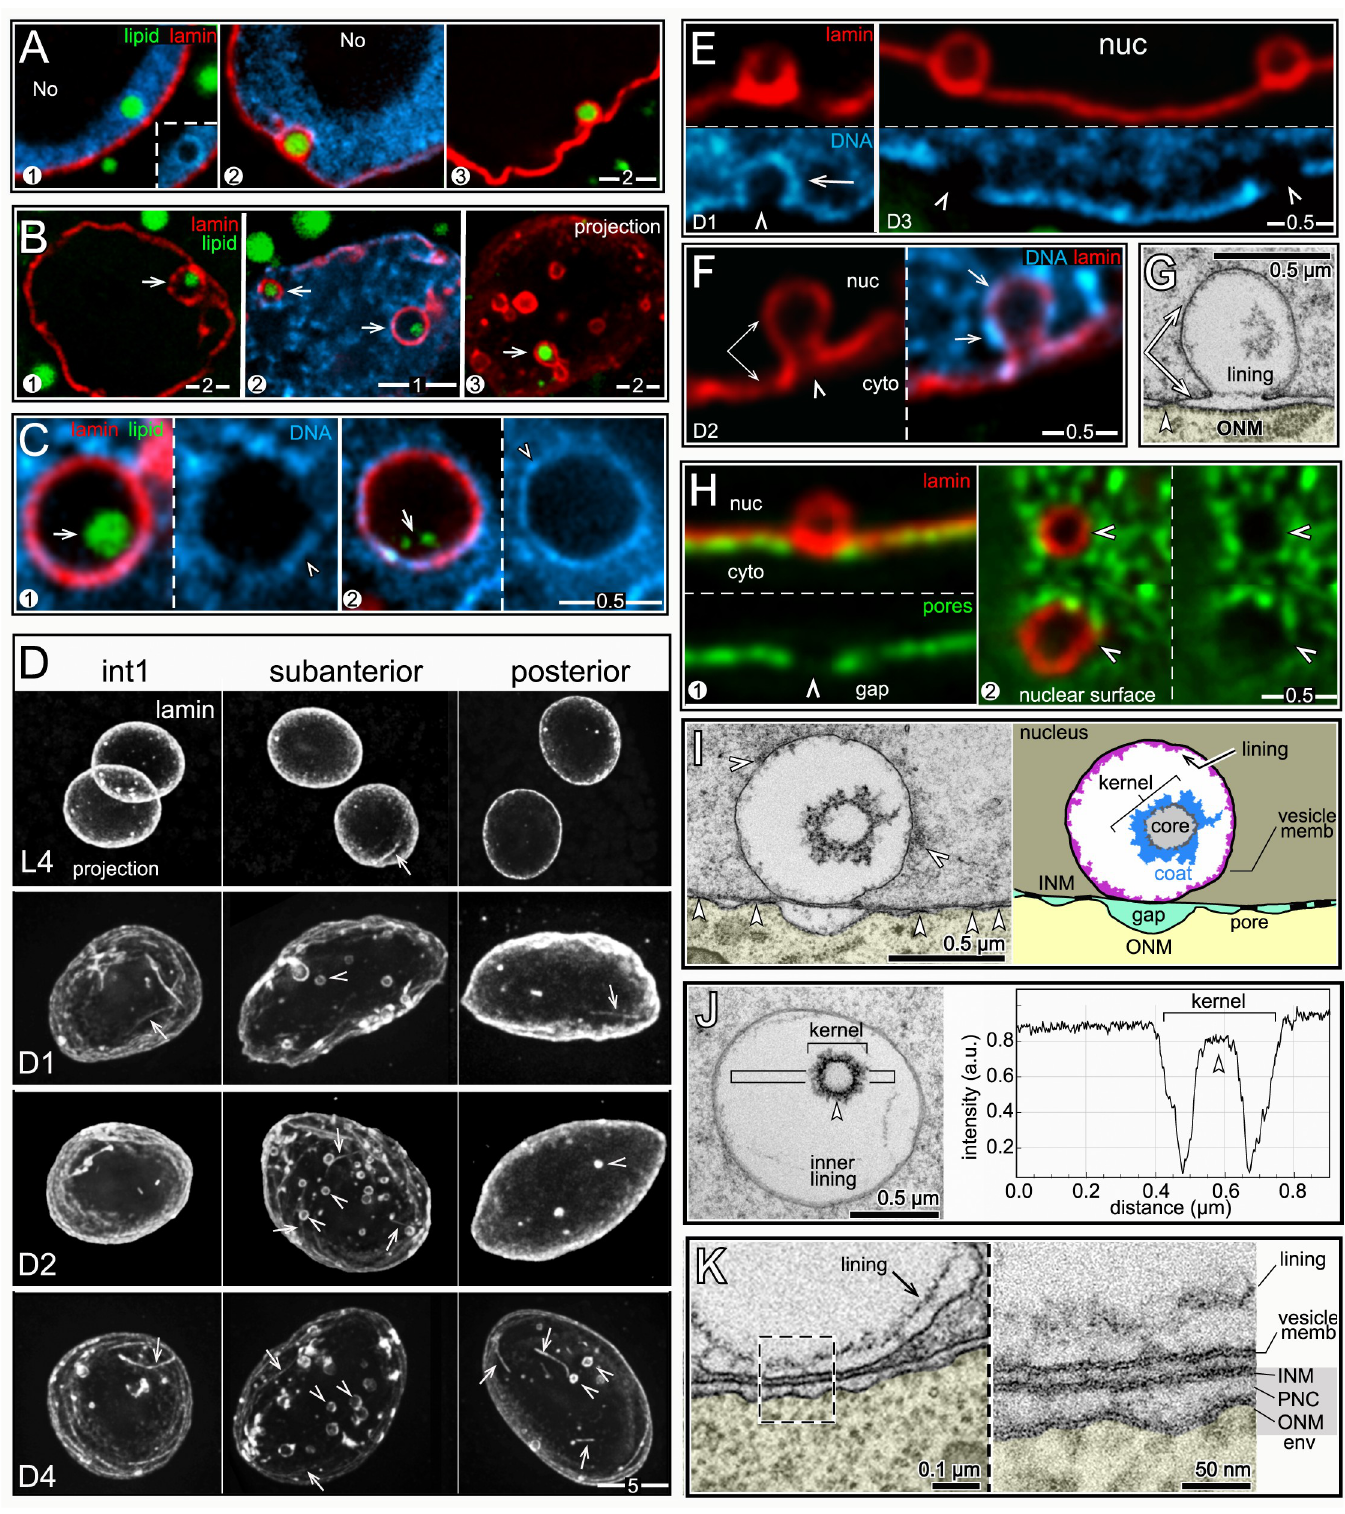
Fig 6. nLDs and lamin sacs. (A) Examples of nLDs with and without lamin coats (red, LMN-1/lamin) in L4 (panel 1) and D1 (panels 2,3) intestinal nuclei. (B) Examples of nLDs that are within, but that do not fill, lamin sacs (arrows). The lamin sacs are closely associated with the nuclear envelope; panels 2 and 3 are tangential planes through the surfaces of D2 and D3 nuclei, respectively. Panel 3 shows a 5 μ m maximum intensity z projection to illustrate the number of lamin sacs; note that only